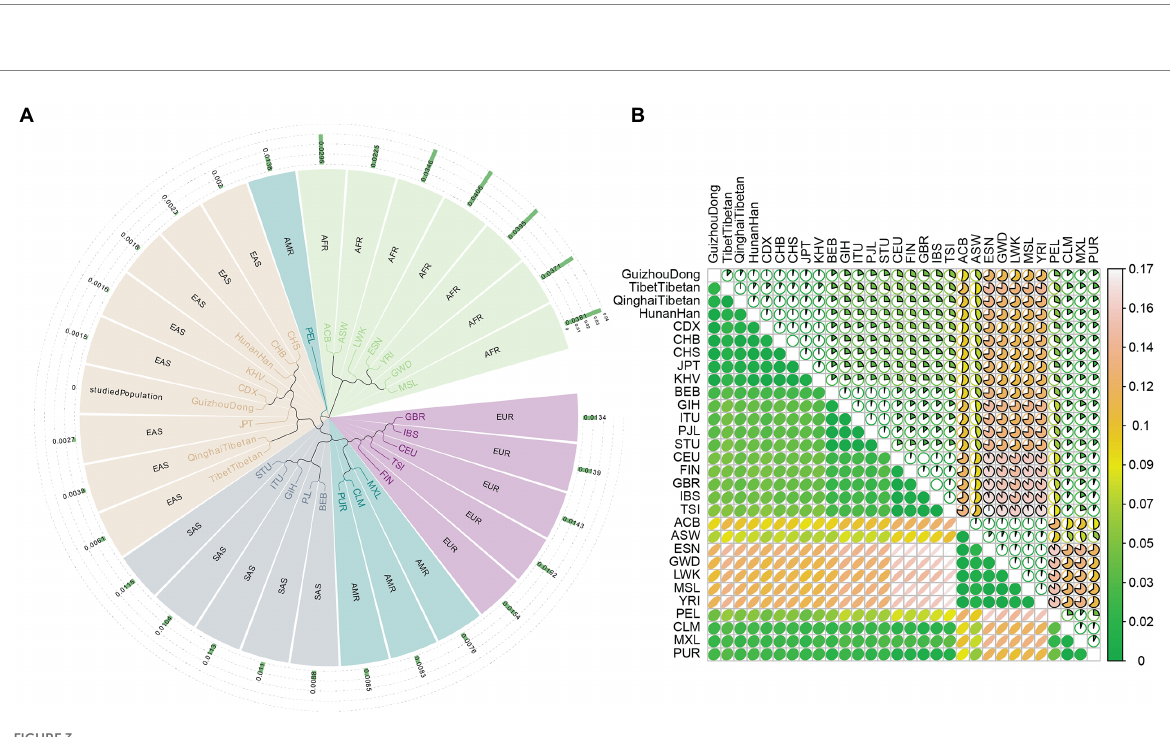
FIGURE 3 The Unweighted pair-group method with arithmetic means-based tree (A) and F ST (B) of the Guizhou Dong and other compared